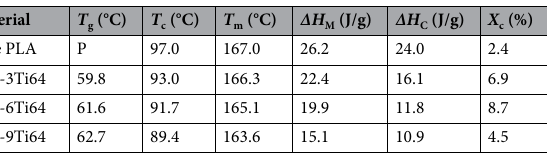
Table 1. Extracted numerical values of different parameters in DSC for PLA-Ti64